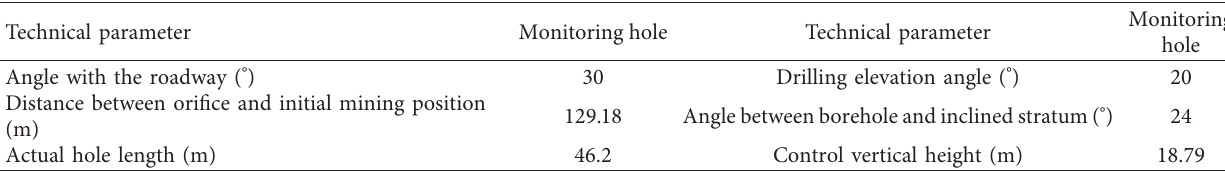
Figure 3: Plane layout sketch of the 11223 working face. Table 1: Design parameters of the monitoring hole in the 11123 floor gas drainage roadway.